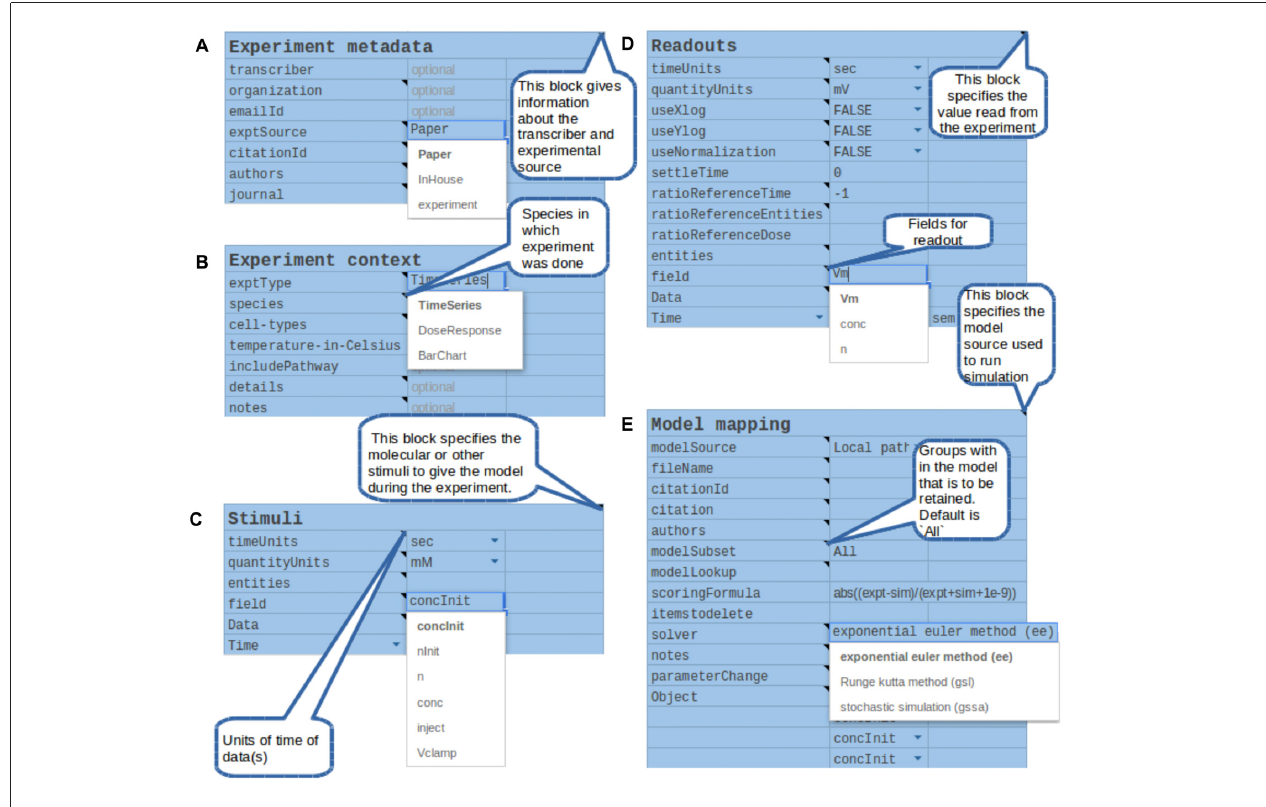
FIGURE 5 | Components of the structured specification of experiment and its mapping to the simulation, implemented as a spreadsheet. In all sections the top line specifies a block of data, and the left column specifies fields to fill in that block. All fields and block titles support tool-tips, that is, pop-up help windows with an explanation of the block and field. These are illustrated here as speech balloons. Fields having a restricted set of options, such as quantity units, are specified with pull-down menus. In several cases there are tabulated sections, which contain value-range limited entries and which can be extended for additional data points. (A) Experiment metadata section. This specifies data about the experiment source and who transcribed it. A menu item is illustrated for the “exptSource” field. (B) Experiment context section. This specifies biological context for the experiment. (C) Stimuli. This section specifies inputs that were given during the experiment: which entity or molecule to change, which parameter was altered, and finally a series of time-value pairs that specifies the stimulus. (D) Readouts. This specifies which entities (such as molecules) were monitored during the experiment, and what values were obtained at each readout time. It may include error bars for each value. (E) Model mapping. This section is the only model-specific part. It indicates a reference model for which the experiment was first tested. For that model it specifies how to obtain the appropriate subset of pathways, molecules and other model entities to use in the simulated “experiment”. The model map next specifies which numerical methods to use. There follows a dictionary of entity names, which maps the experimenter’s naming scheme to unique entity names in the simulation. Finally, there is a table of parameters that have to be changed so that the model matches the experimental conditions. For example, some of the molecules in the experiment may now be buffered to specified